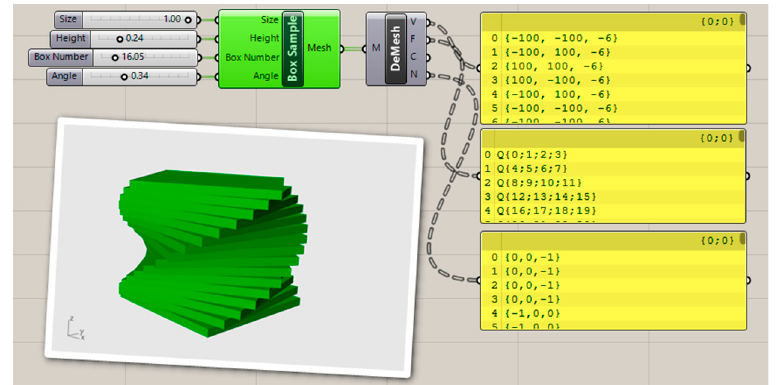
Figure 5. Sample Grasshopper3d definition.